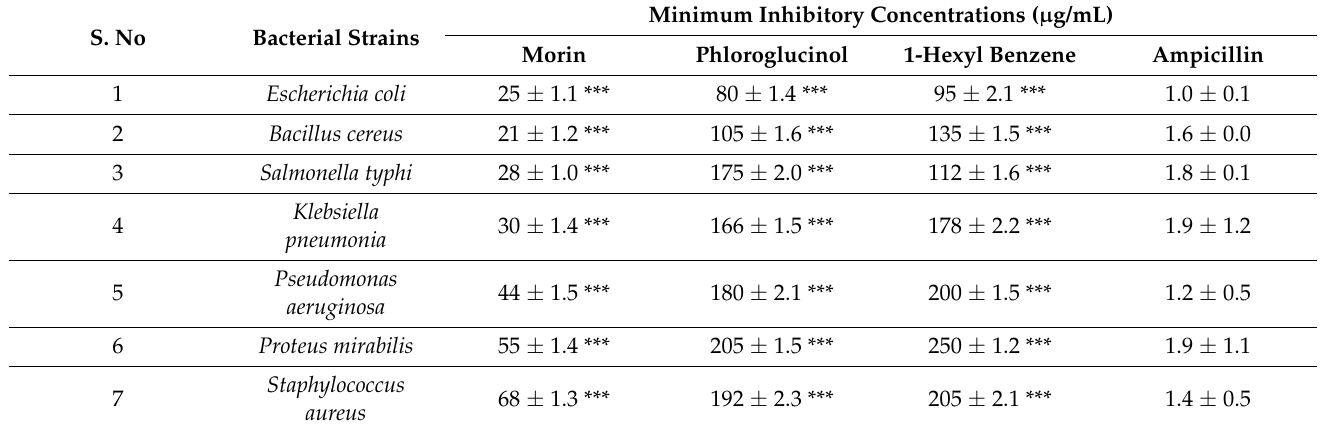
Table 5. Minimum inhibitory concentrations of morin against Gram-positive and Gram-negative bacterial strains. S.